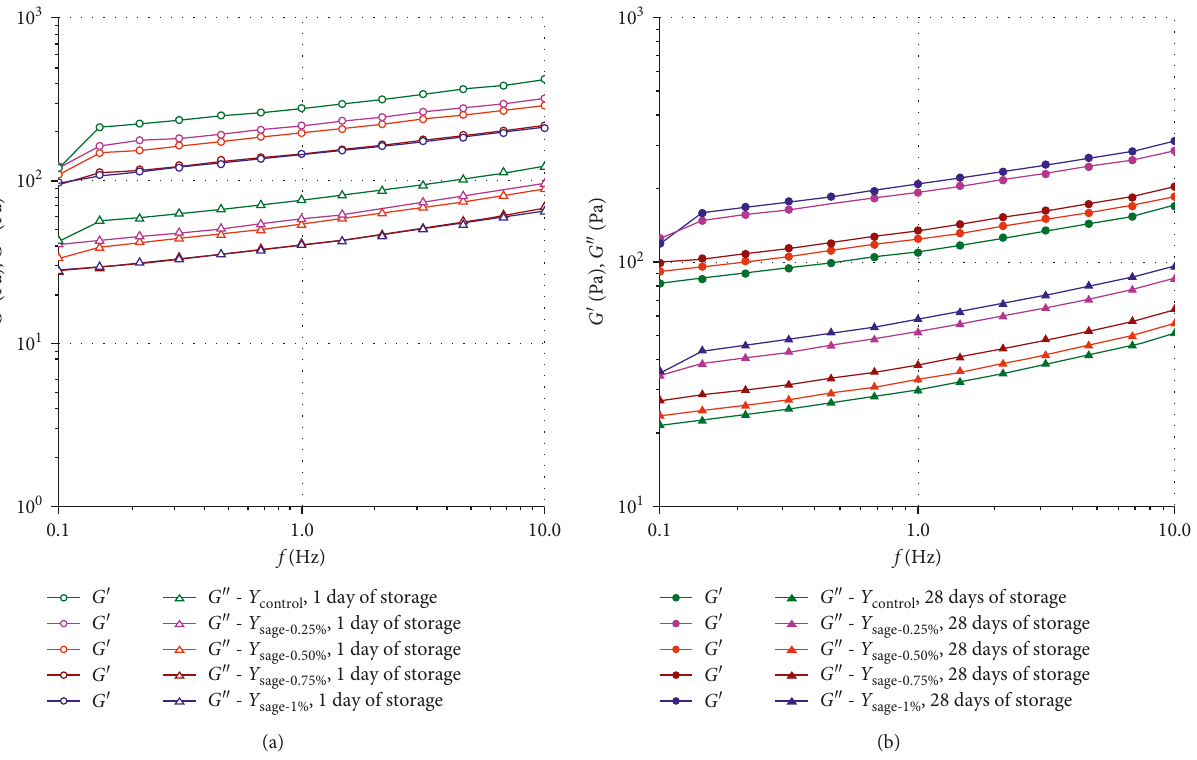
Figure 7: Viscoelastic properties of yogurt with sage ( Salvia officinalis L.) extract: (a) 1 day of storage; (b) after 28 days of